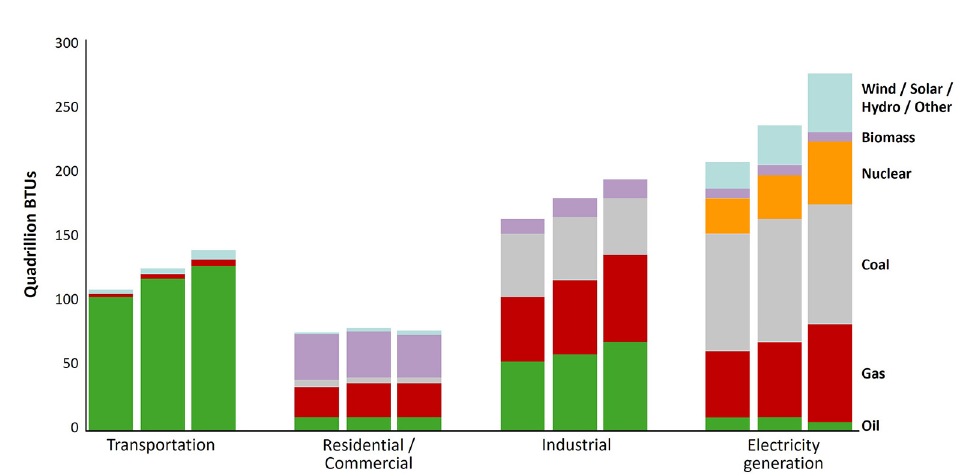
Fig. 16. – Global energy demand by sector, 2016–2040 (Source: ExxonMobil,